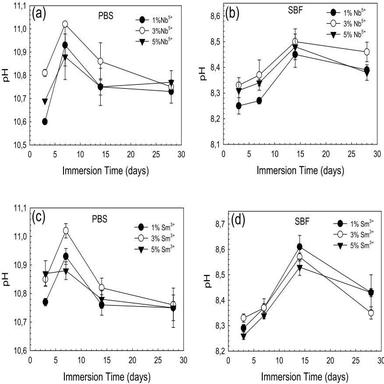
Demonstration of the change in the pH of the PBS (left column), and SBF (right column) after contact with the (a), (b) Nb5+; (c),(d) Sm3+-containing bioactive glass particles for different immersion times. The initial pH of the PBS and the SBF is 7.4.